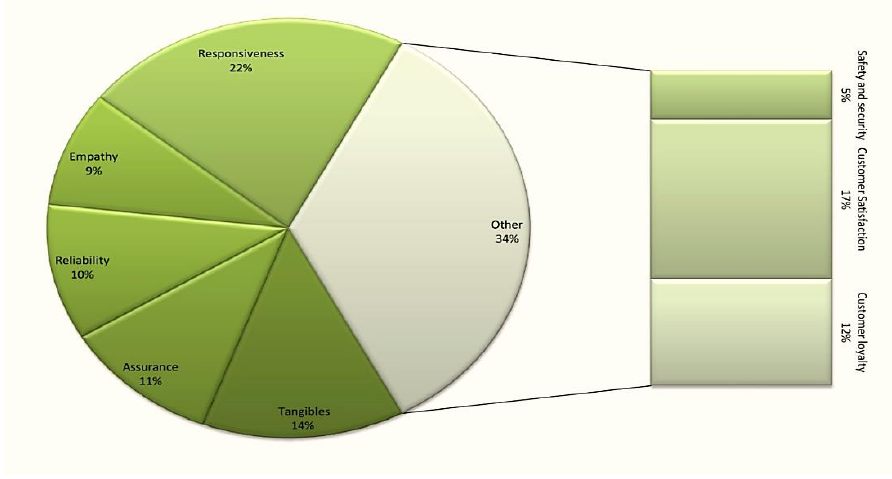
Fig. 5. Pie chart of the frequency percentage of the RL Airqual dimension quality measurements from the respondents’ point of